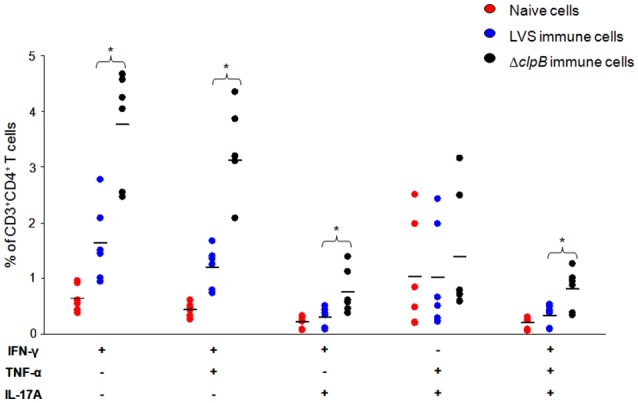
Percentage of CD4+ and CD8+ T-cells expressing IFN-γ, IFN-γ, and TNF-α, or TNF-α and IL-17, or all three cytokines in cultures with naïve (red circles), LVS-immune (blue circles) or ΔclpB-immune (black circles) splenocytes incubated with LVS-infected BMDM for 72 h. The percentages are expressed in relation to the CD3+ population. Results shown represent data from three experiments. *
P < 0.05 according to Wilcoxon's signed rank test for the pair-wise comparisons between LVS- and ΔclpB-immune data for each cytokine combination.